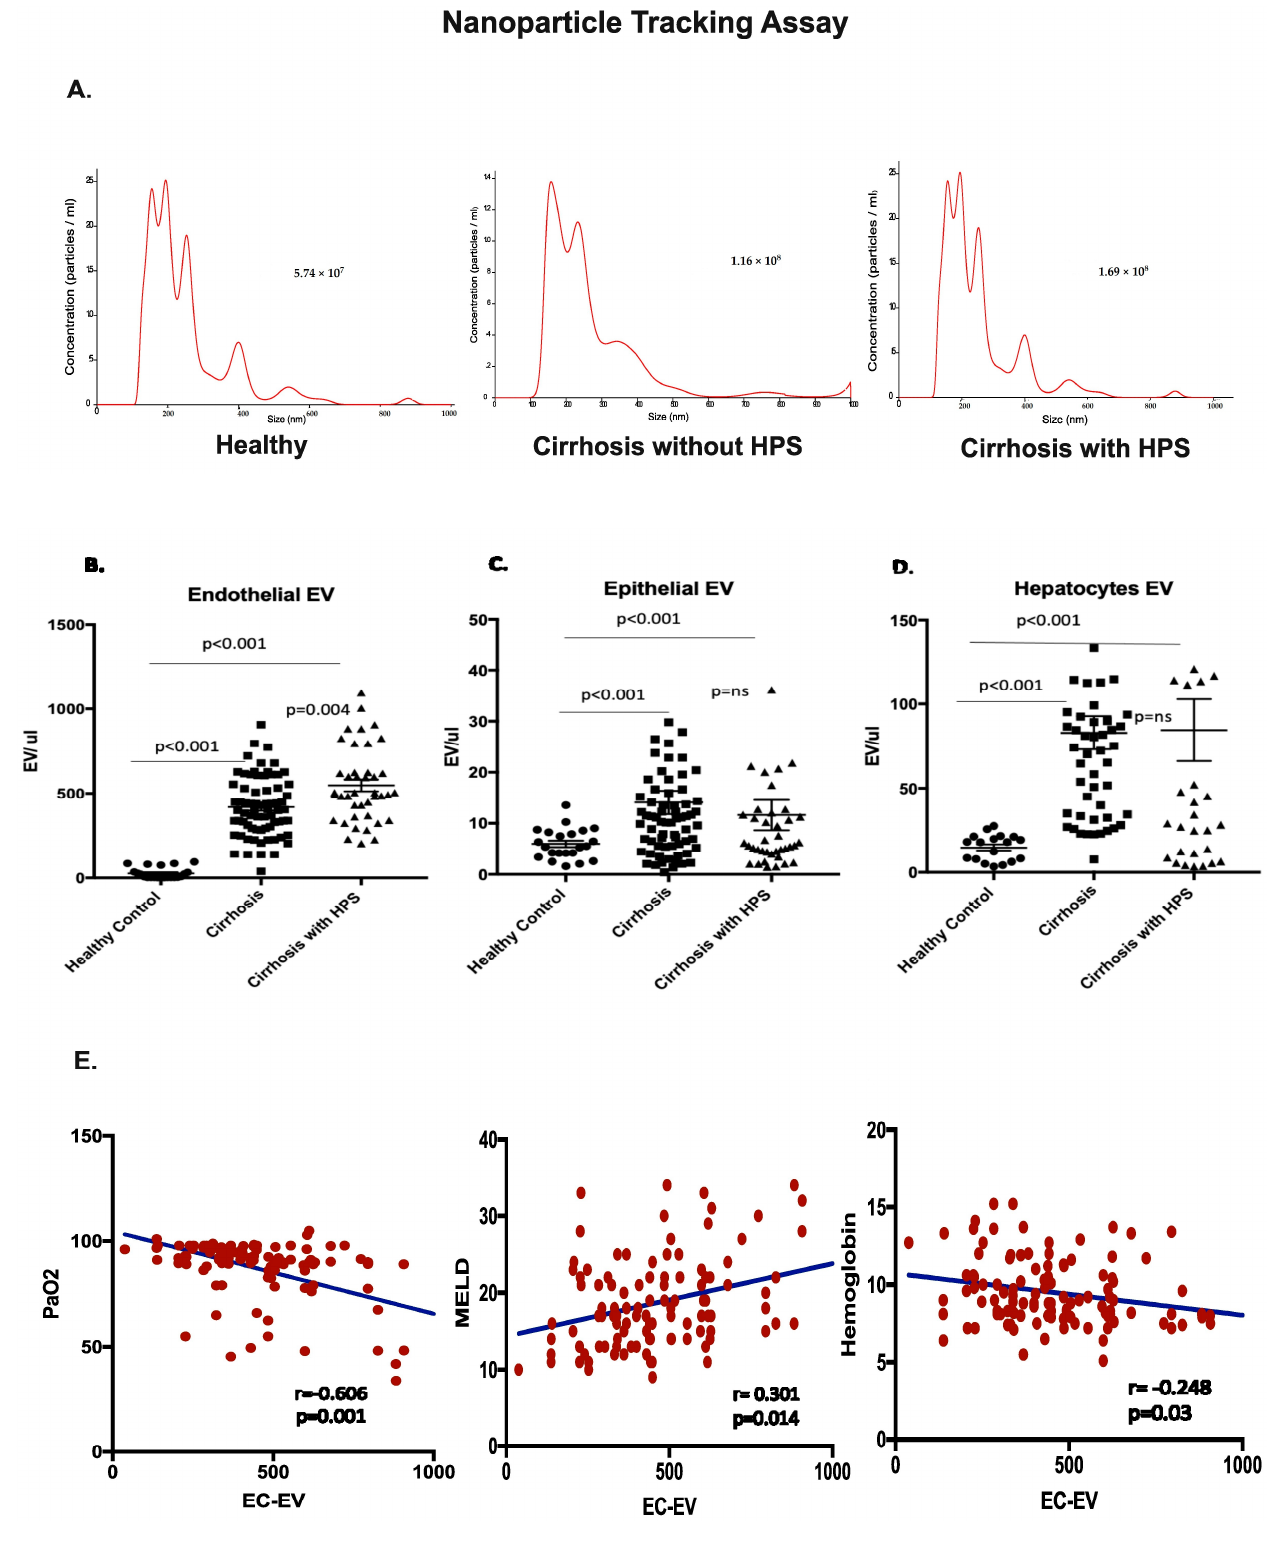
Figure 1. ( A ) Representative images from NanoSight NS300 show the quality, size, and concentration of total EVs isolated from plasma from healthy controls, patients with HPS, and patients without HPS. The Y-axis is concentration (particles/mL), and the X-axis is size in nm. ( B – D ) The dot plots show the absolute counts in EV/ µ L as measured using flow cytometry associated with endothelial cells (EC-EVs), epithelial cell EVs, and hepatocyte EVs. ( E ) The scatter plot shows the EC-EVs correlation with PaO2, MELD, and